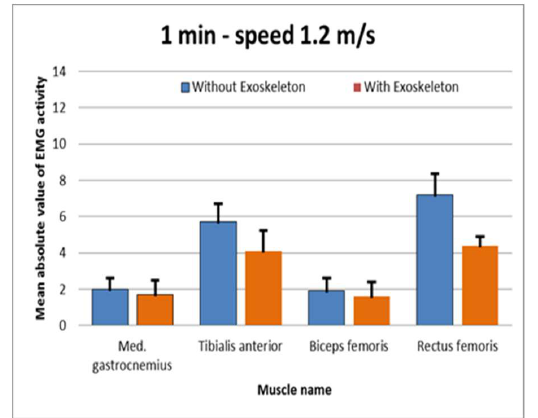
Fig. 15. Mean EMG activity of the right leg muscles of the subject with lower limb weakness during walking on treadmill at fixed speed 1.2m/s for 1